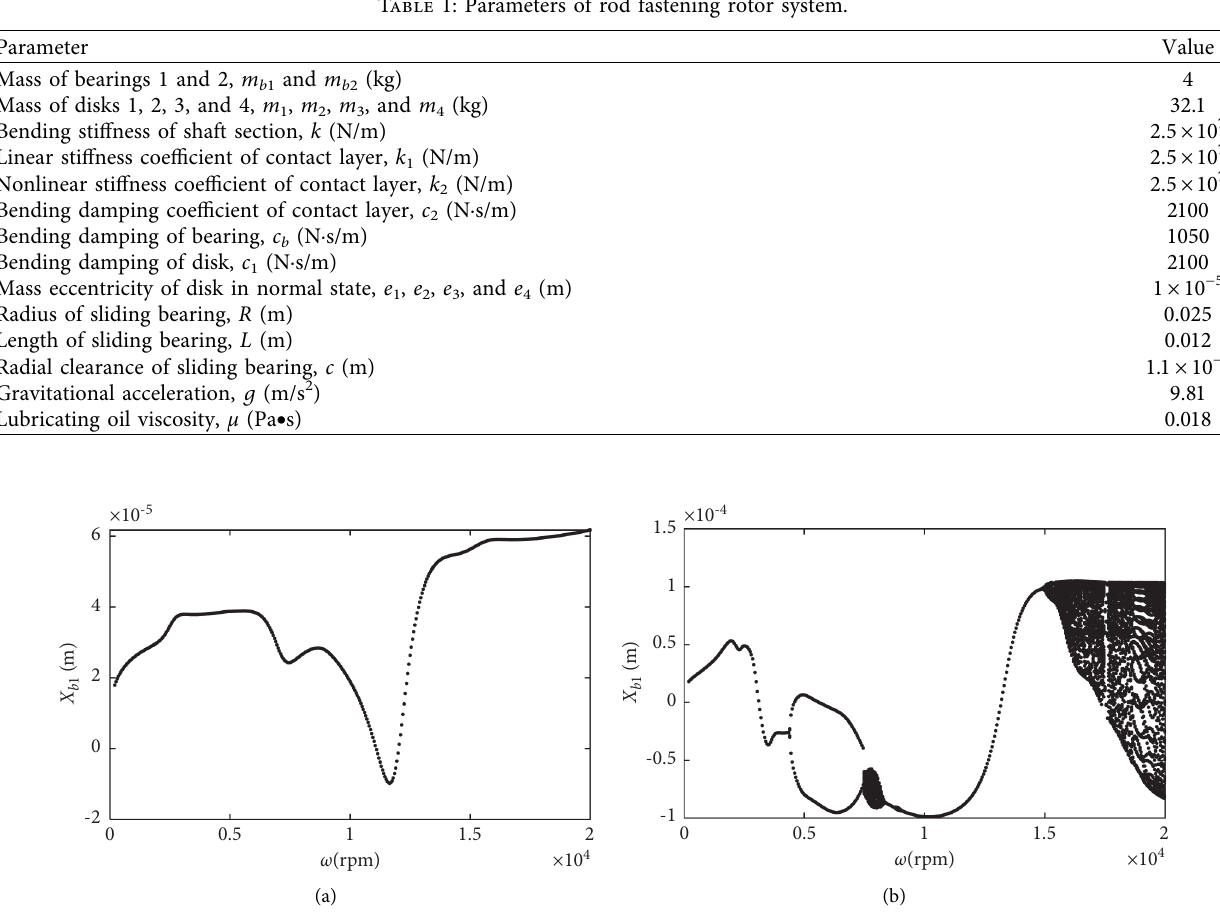
Figure 4: Bifurcation diagram of bearing vibration, (a) normal state and (b) fault